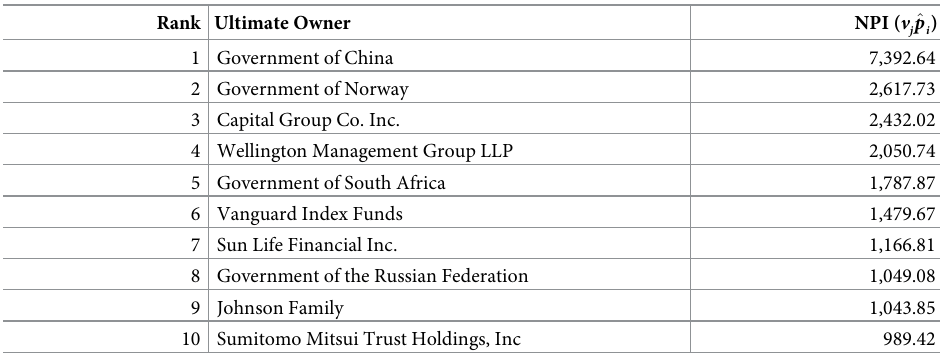
Table 2. Shareholders with top-10 NPI in 2016.